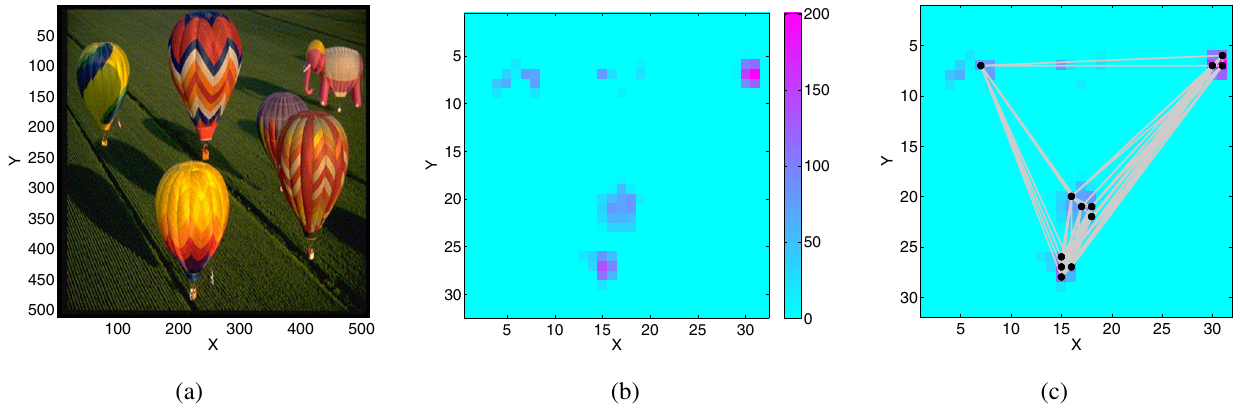
Figure 13 . Focus of attention scan paths: (a) Input image used to generate the saliency map. (b) Saliency map obtained from the SaliencyToolbox , with the default parameters. The colors code for the saliency of the corresponding pixel in the input image. The intensities were re-scaled to the range 0 to 200, to represent the mean frequencies of the spike trains used to stimulate the chip. (c) Focus of attention scan path generated by the 32 × 32 selective-attention chip, superimposed on the saliency map. The black dots show the fixation points, the grey lines connect consecutive